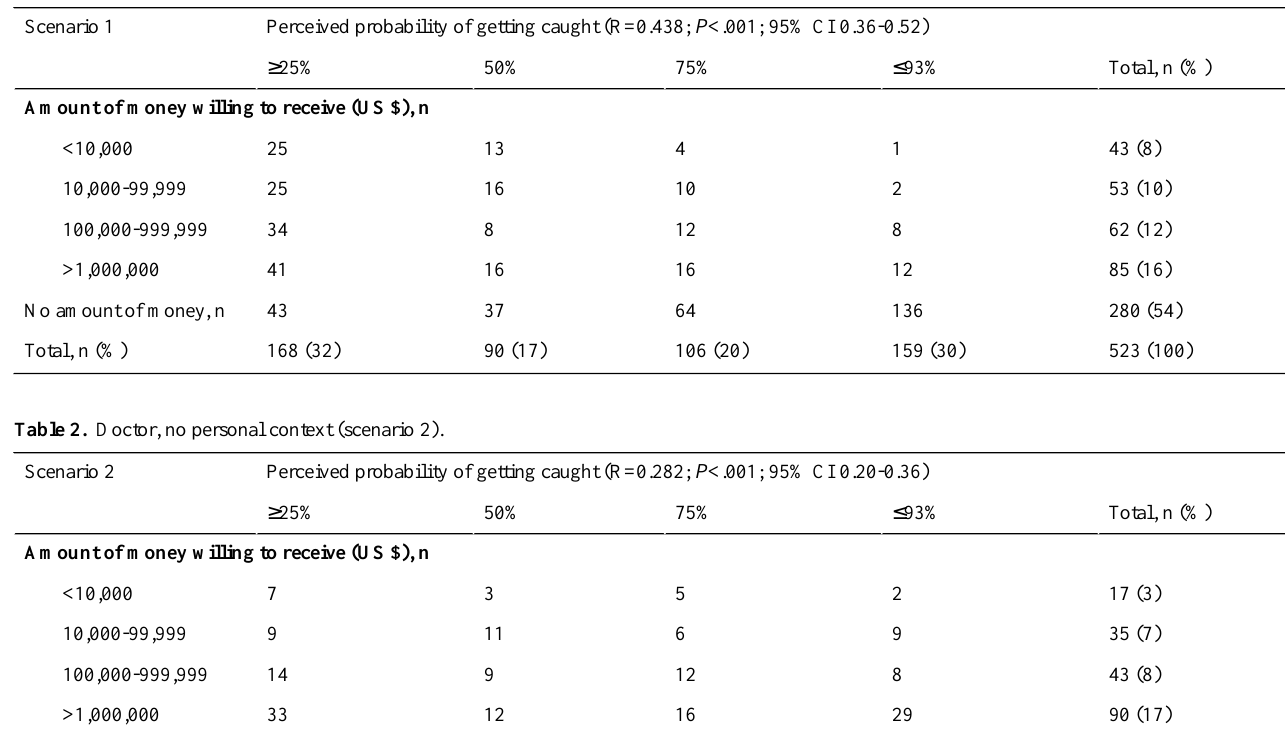
Table 1. Nurse, no personal context (scenario 1).